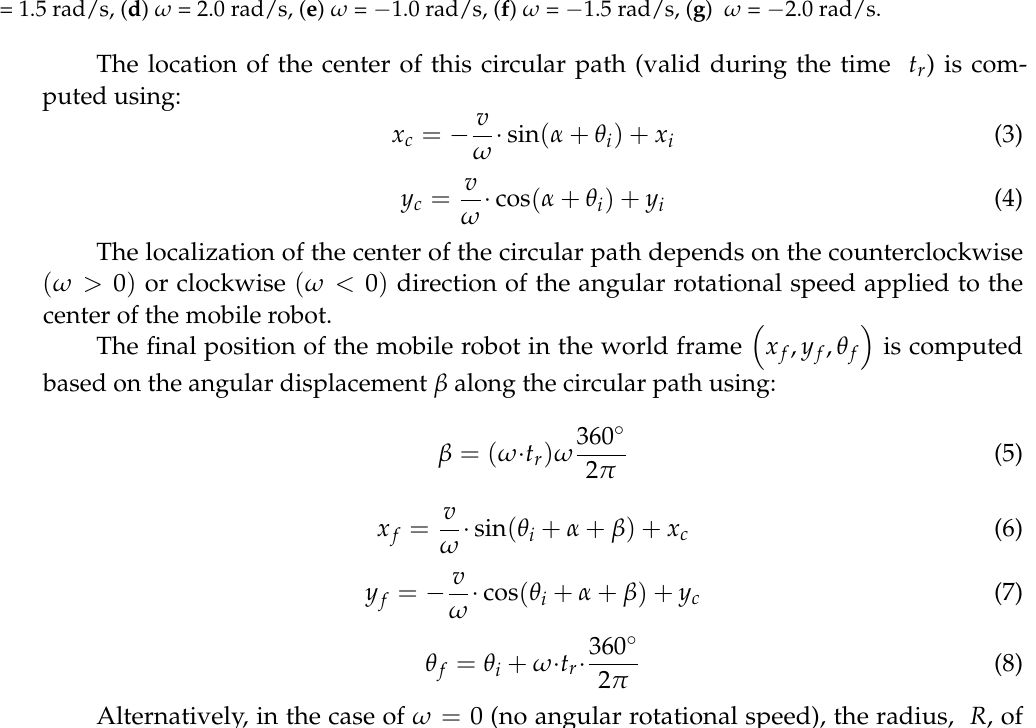
Figure 4. Simulation of the trajectories generated by motion commands 𝑀 = ( 𝑣,𝛼, 𝜔, 𝑡 𝑟 = 10𝑠 ) . The starting point is (𝑥 = 0, 𝑦 = 0, 𝜃 = 0) , and the velocity 𝑣 = 0.3 m/s. Showing 8 different angular orientations 𝛼 : 0° (red), 45° (green), 90° (blue), 135° (cyan), 180° (black), 225° (yellow), 270° (magenta), 315° (olive), and different angular rotational speeds: ( a ) 𝜔 = 0.0 rad/s, ( b ) 𝜔 = 1.0 rad/s, ( c ) 𝜔 = 1.5 rad/s, ( d ) 𝜔 = 2.0 rad/s, ( e ) 𝜔 = − 1.0 rad/s, ( f ) 𝜔 = − 1.5 rad/s, ( g ) 𝜔 = − 2.0 rad/s.